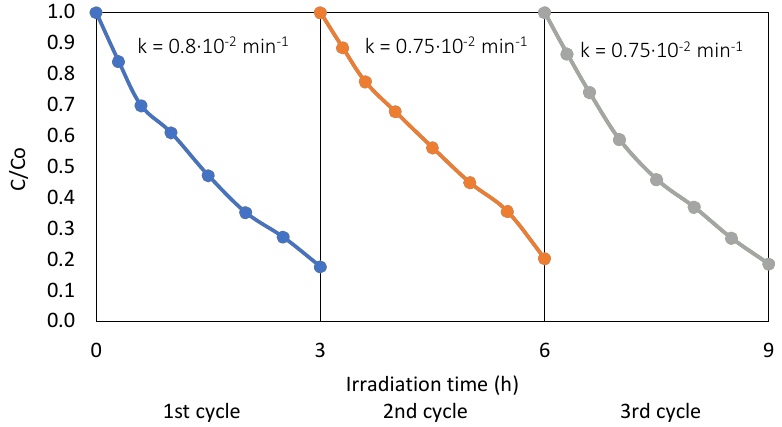
Figure 15. Efficiency of UV-Vis phenol degradation in the presence of a defective TBT-HIO 3 _50 photocatalyst measured in the three subsequent cycles.